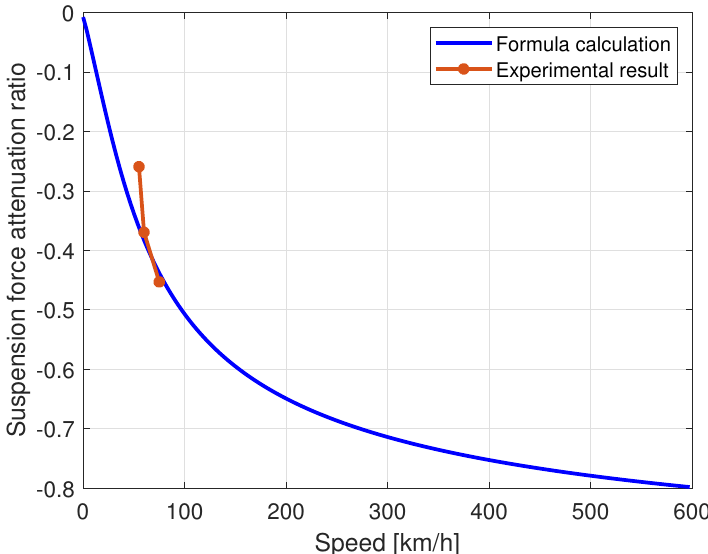
Figure 9. Influence of eddy current on suspension force.